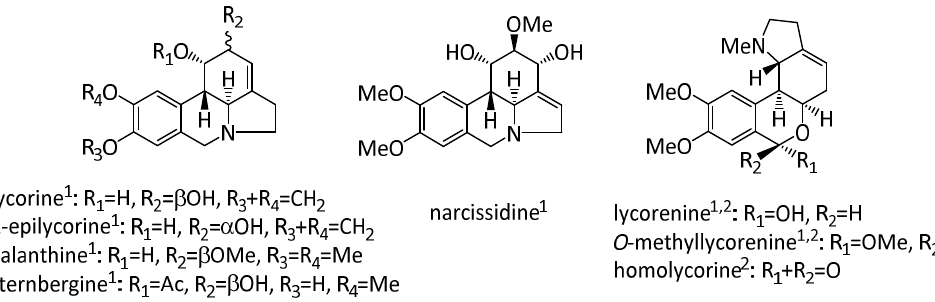
Figure 1. Alkaloids isolated from N. nevadensis 1 [19] and N. muñozii-garmendiae 2 [20].